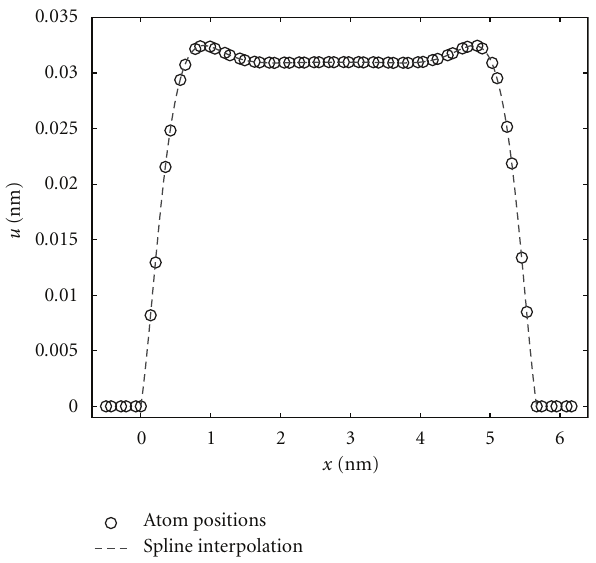
Figure 7: Atomistic simulation of the deflection of a 6nm graphene sheet with d = 0 . 31 nm. Note that the continuum model tries to match only the deflected part of the sheet, that is, from x = 0 to about x = 5 . 6 in this